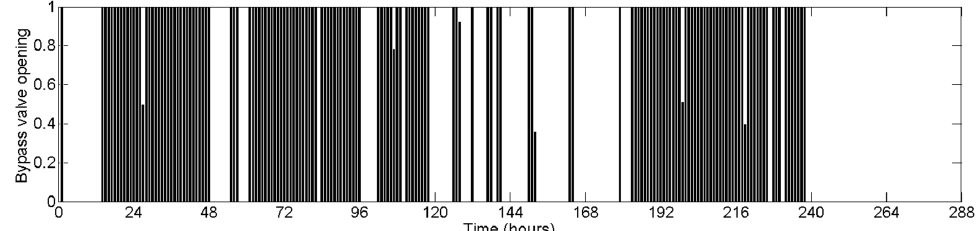
11 of 19 Figure 6. Fitness values of the smart seed and the genetic algorithm (GA) outputs for different population sizes. Figures 7 and 8 show the optimal bypass valve operation schedules found for the single turbine case at location 3 for the micro turbines NC 100–200 and NC 150–200, respectively. In these figures, black vertical bars are used to indicate the degree of opening of the bypass valve. A bypass valve